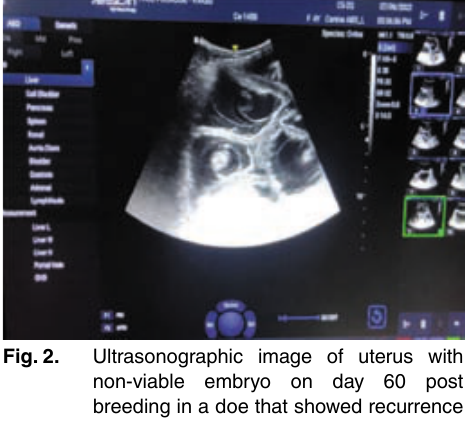
Fig. 2. Ultrasonographic image of uterus with non-viable embryo on day 60 post breeding in a doe that showed recurrence of